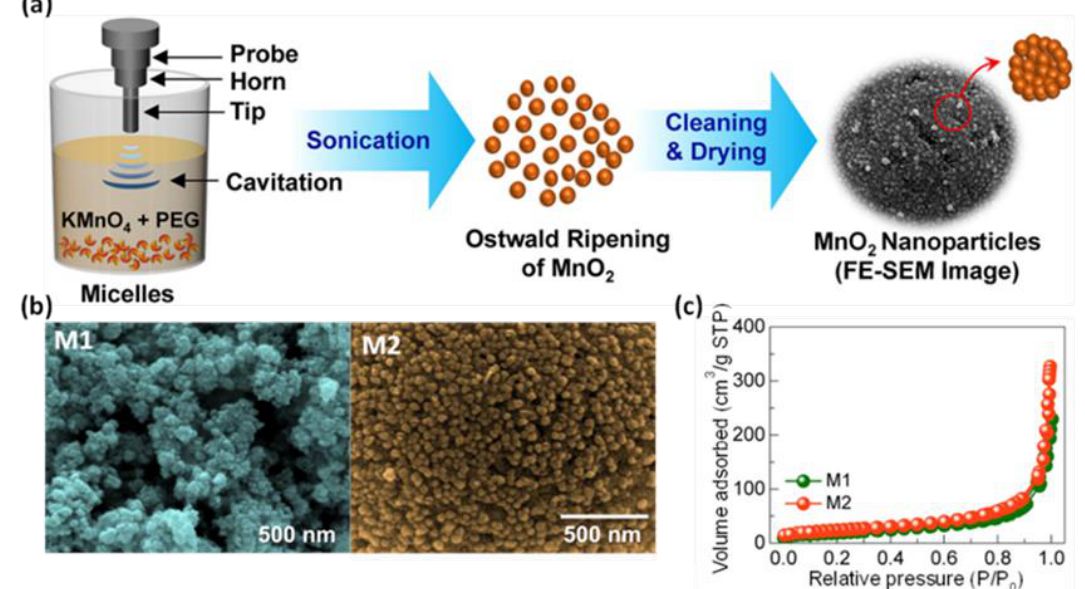
Figure 4. ( a ) Schematic illustration of synthesis of MnO 2 nanoparticles via a sonochemical route, ( b ) SEM images, and ( c ) nitrogen isotherms of samples irradiated for 15 min (M1), and for 30 min (M2) [49]. Reproduced with permission from ref. [49]. Copyright 2018, Elsevier Ltd. and Techna Group S.r.l. Table 2. Porous metal oxides obtained via sonochemical-assisted synthesis. Sample SSA [m 2 /g] Ref.